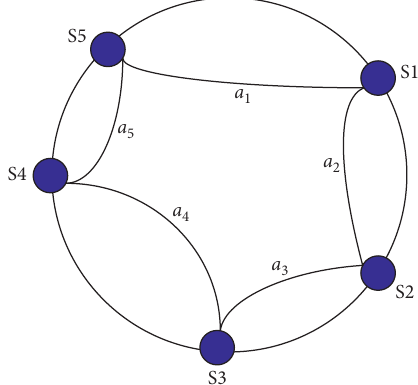
Figure 5: Cache node location relationship on the hash ring under CHWBL